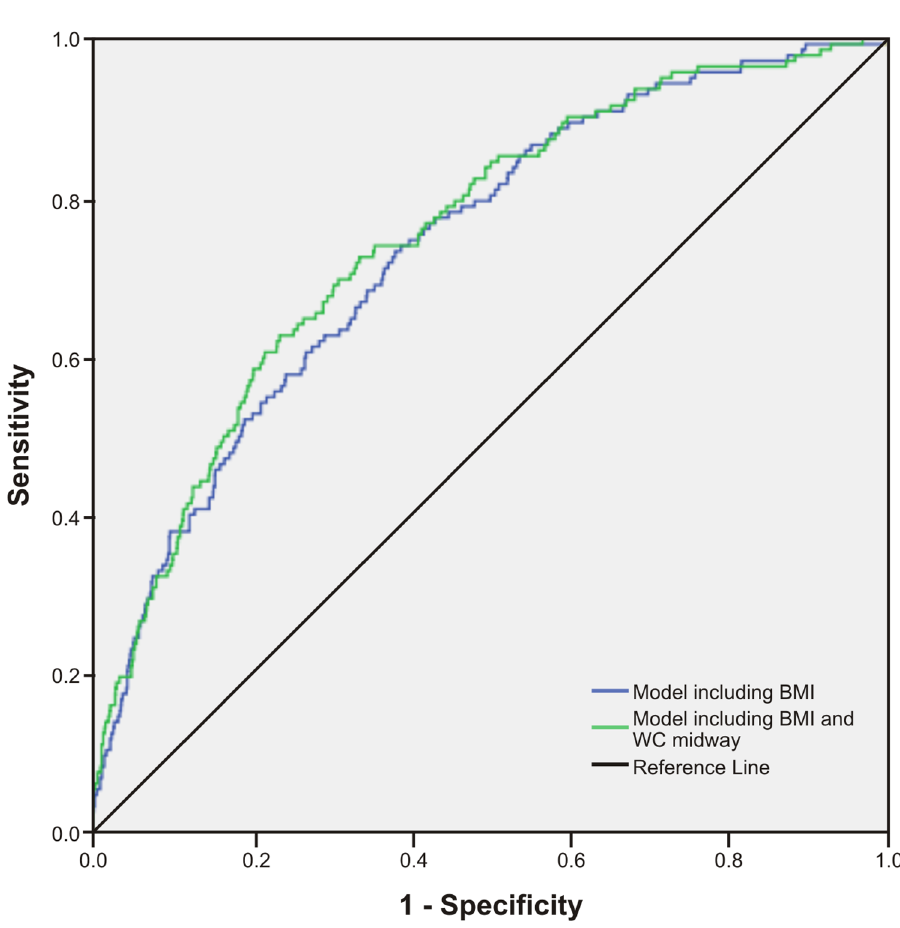
Fig 6. Receiver operating characteristic curves for prediction models to discriminate subjects with type 2 diabetes. Figures show ROC curves for a model including BMI and a model including BMI and WC midway. All models include age and